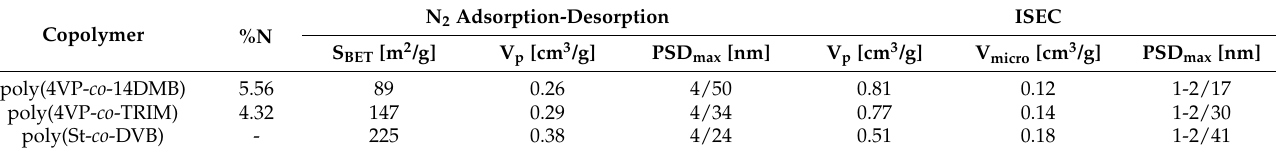
Table 1. Percentage of nitrogen content and parameters characterizing porous structure of 4VP copolymers and poly(St- co -DVB) determined by means of nitrogen adsorption-desorption method and